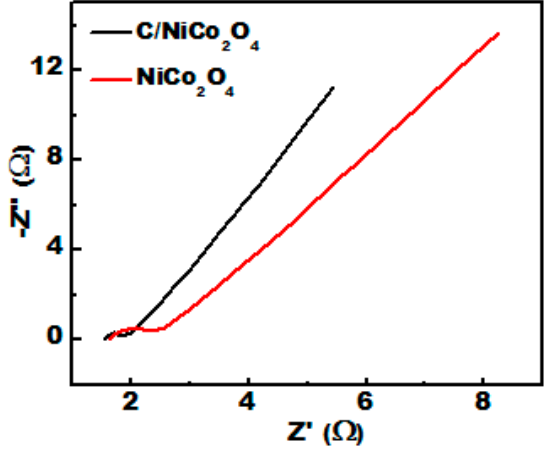
Figure 9. Nyquist plots of C/NiCo 2 O 4 and NiCo 2 O 4 nanofibers obtained at room temperature.